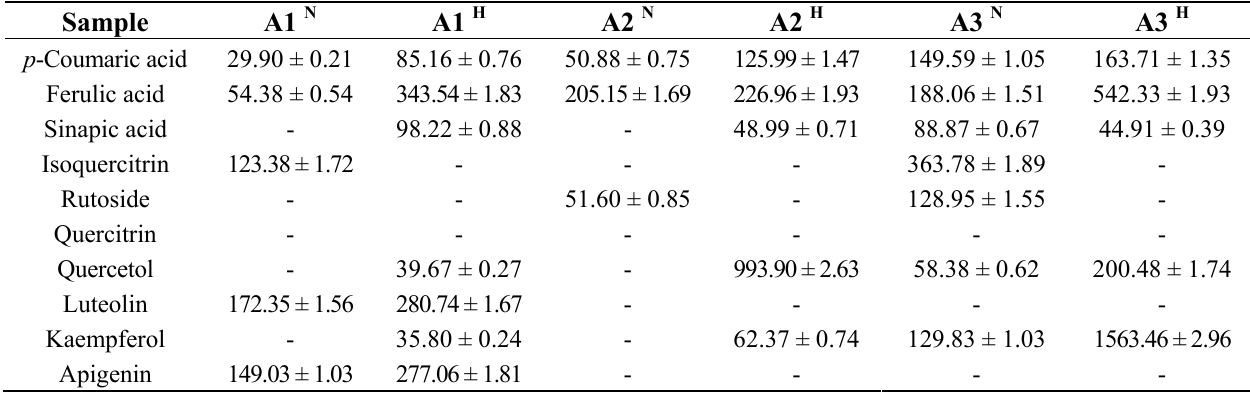
Table 1. The polyphenolic compounds content of Allium species ( μ g/100 g vegetal product).